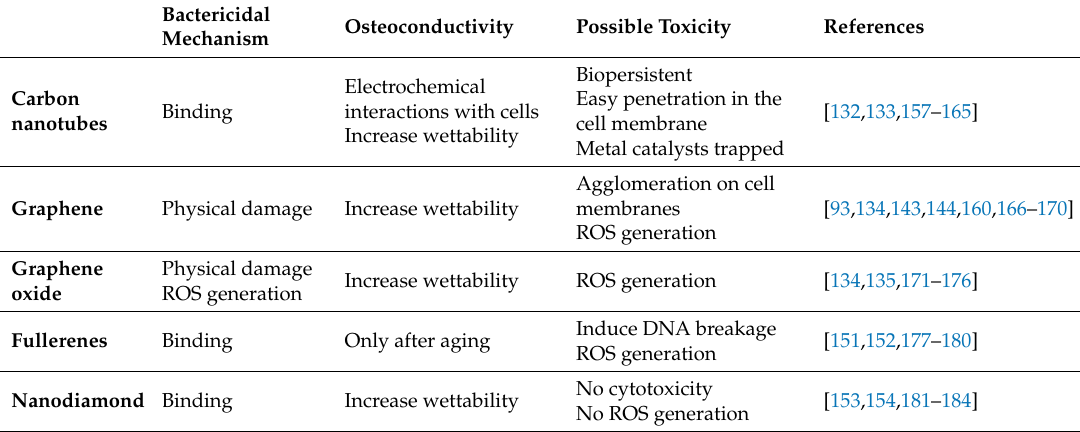
Table 1. Properties of carbon-based nanomaterials for bone tissue engineering